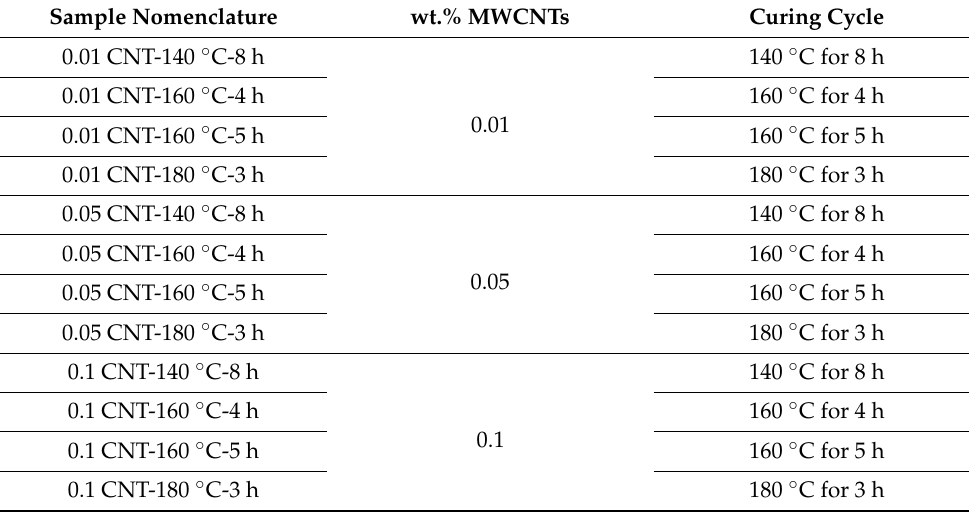
Table 1. Summary of nomenclature for the different